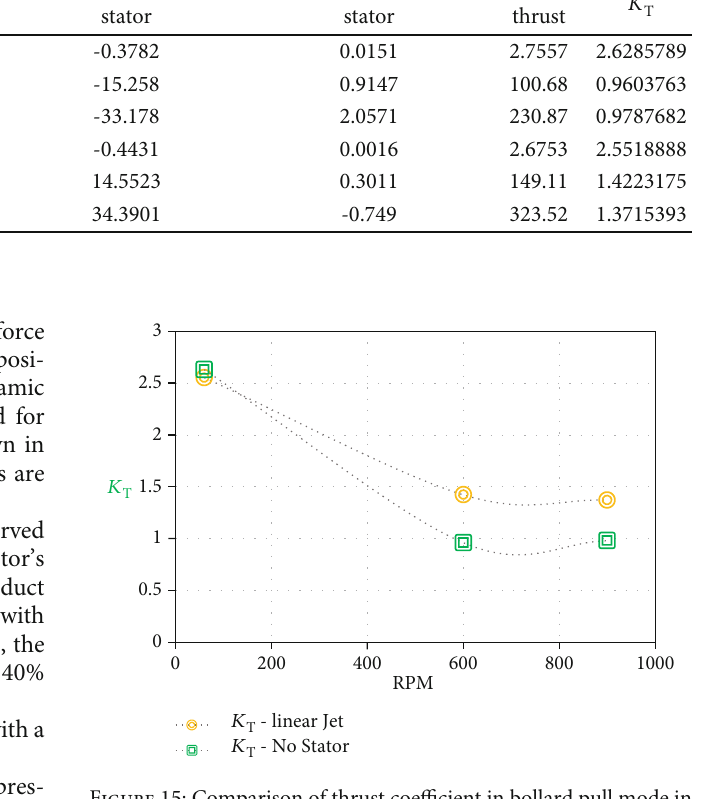
Figure 15: Comparison of thrust coe ffi cient in bollard pull mode in the presence and absence of a